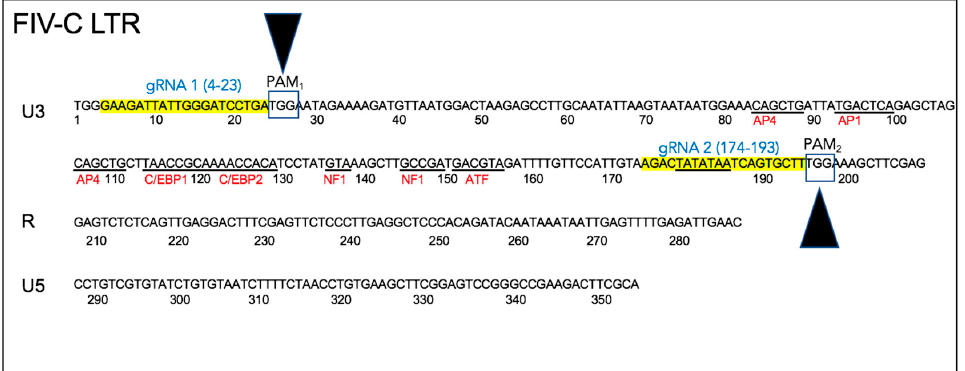
Figure 2. Feline immunodeficiency virus (FIV)-C 5’ and 3’ long terminal repeats (LTR) (U3, R, and U5 regions). The guide RNA sequences are depicted in yellow (gRNA1 and gRNA2) while the two proto-spacer adjacent motif (PAM) sites (PAM 1 and PAM 2 , endonuclease cut sites) are in boxes and indicated by the black arrowheads. Known transcription factor binding motifs and the TATA box are underlined.